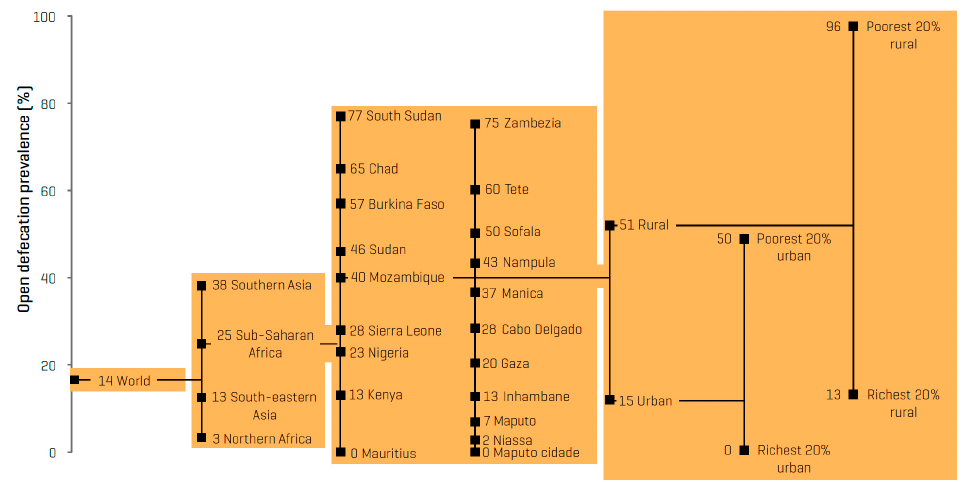
Figure 3. Example from Mozambique on how average access values mask massive disparities in household coverage. Reproduced with permission from World Health Organization and UNICEF [18].